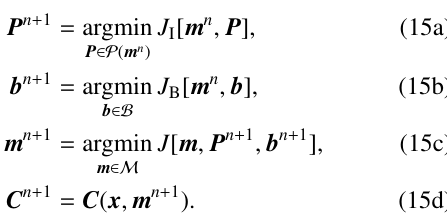
ping criterion is